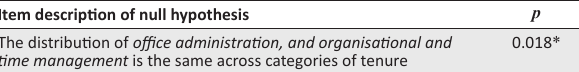
TABLE 2: Relationship between length of service and items.